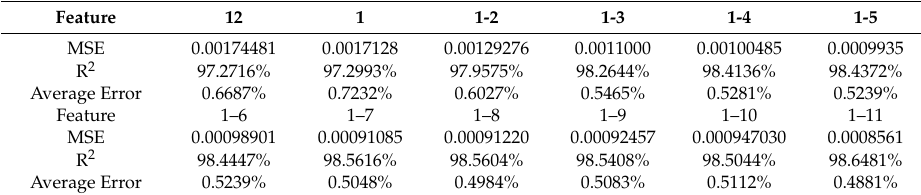
Table 3. performance parameters.